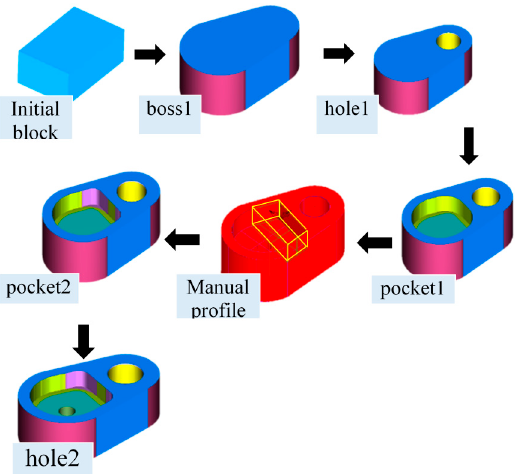
Figure 16. Stages of the KBM applied to the piece Link 1_4 bars within the machining process.